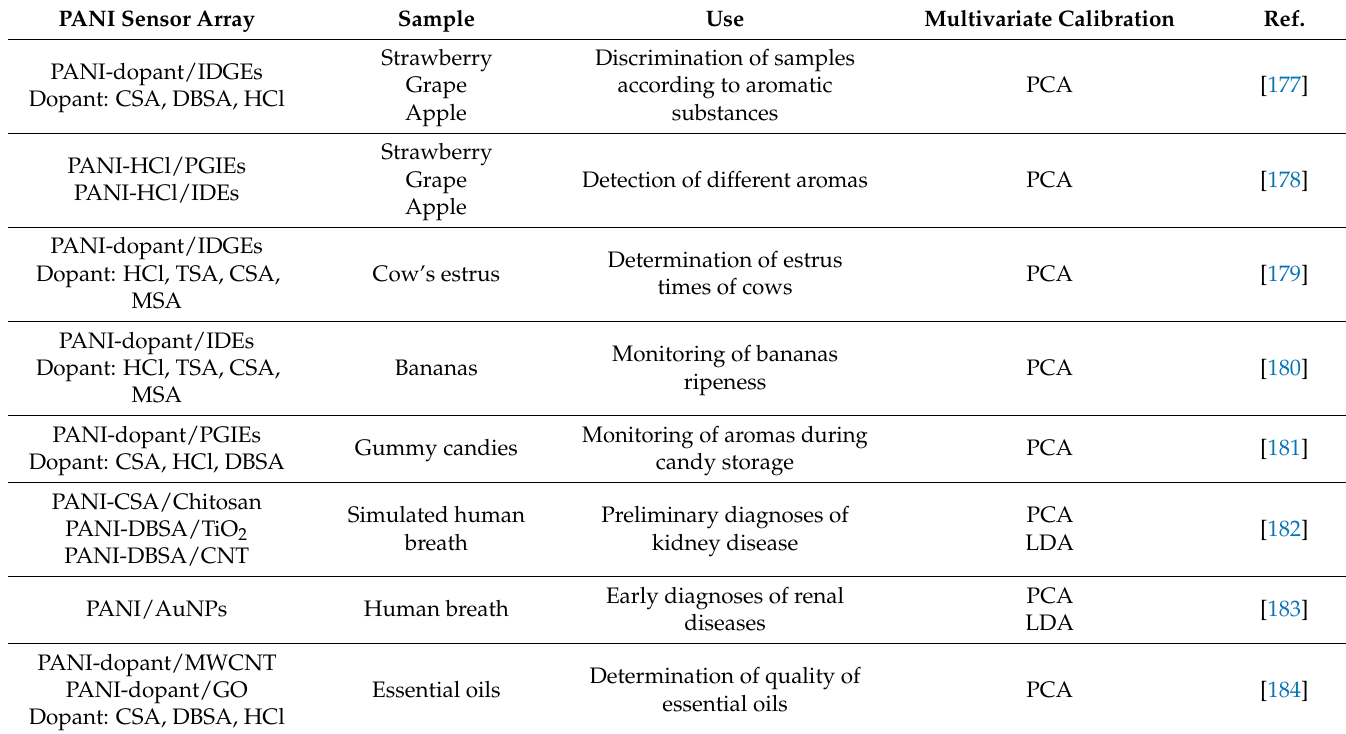
Table 4. Electronic noses based on polyaniline (PANI) films applied for analytical purposes in the last decade. PANI Sensor Array